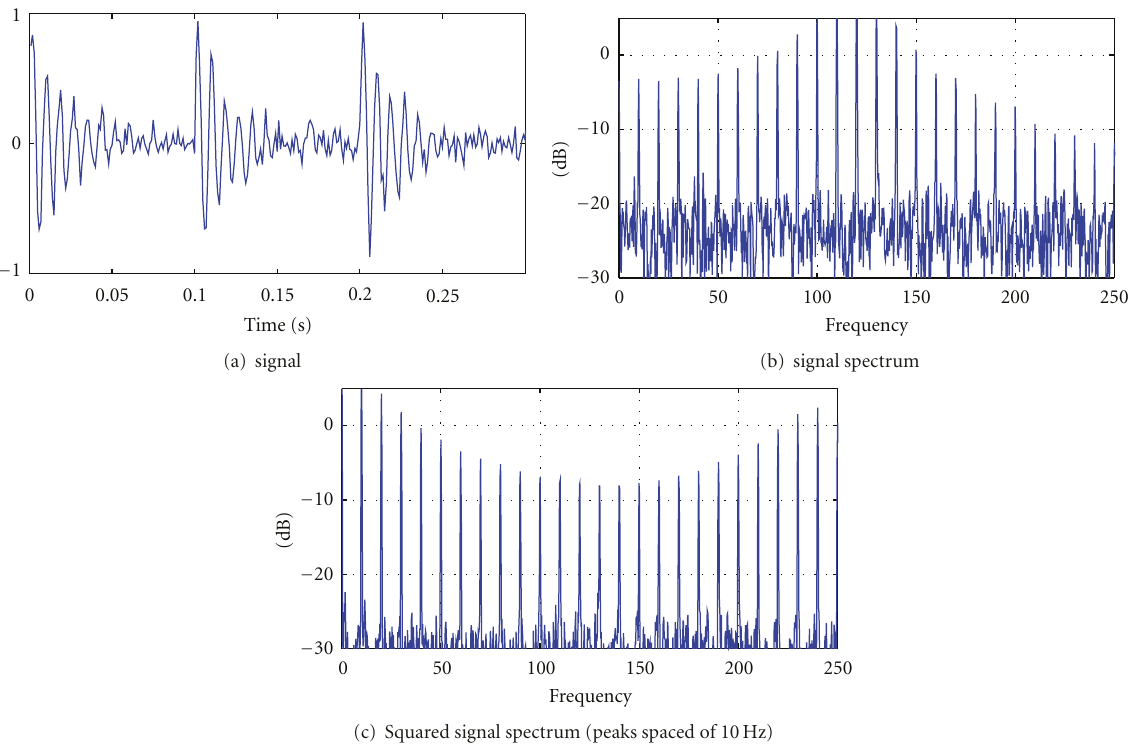
Figure 1: Analysis of a series of impulses.